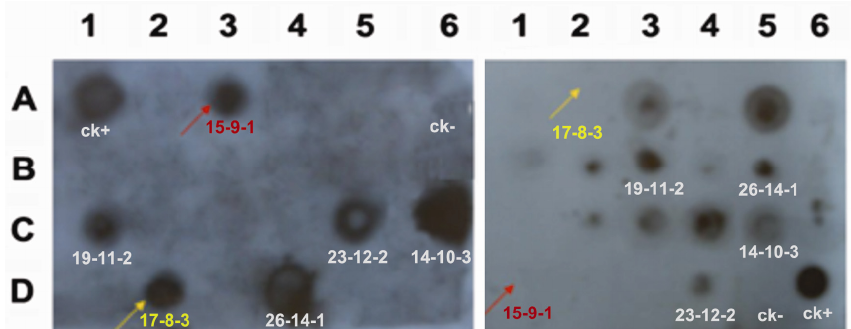
Figure 3. Segregation of target genes and selectable marker gene in T DNA dot blot analysis. Two segregated transgenic lines are highlighted in red for 15-9-1 and yellow for 17-8-3, respectively. Transgenic lines that have only Hpt are not indicated. For SBgLR (left), A1 represents positive control and A6 represents negative control. For Hpt (right), D6 represents positive control and D5 represents negative